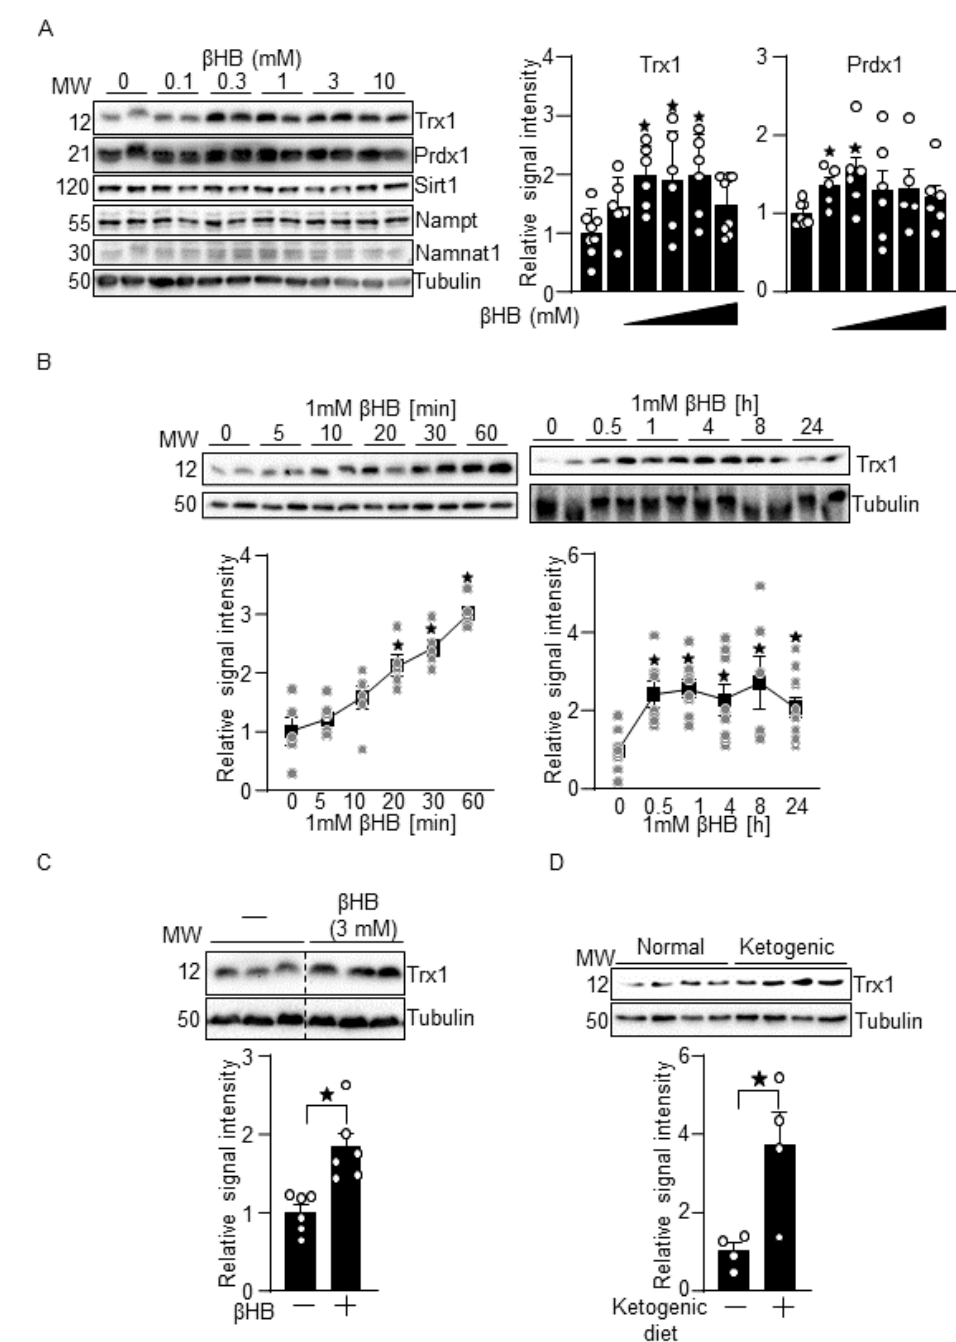
Figure 1. β HB upregulates Trx1. ( A ) Dosage effect of β HB on Trx1 expression. Cardiomyocytes were treated with the indicated concentrations of β HB for 16 h. n = 6–8 (Trx1) and 5–7 (Prdx1). ( B ) Time-dependent effect of 1 mM β HB on Trx1 in cardiomyocytes. n = 5–7. ( C ) β HB upregulates Trx1 in cardiac fibroblasts. Cardiac fibroblasts were treated with 3 mM β HB for 16 h. n = 6. ( D ) Ketogenic diet consumption upregulates Trx1 in the heart in vivo. n = 4. Western blot analyses with indicated antibodies were performed. * p < 0.05 ( A – D